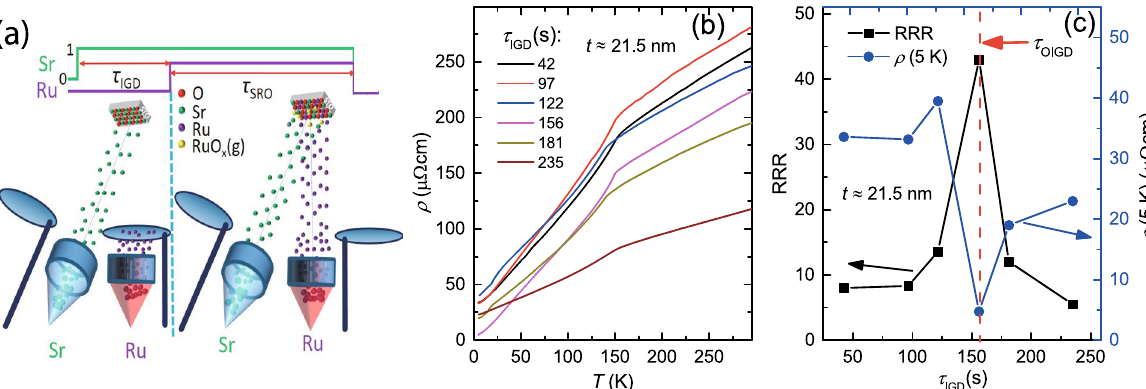
Figure 1. The influence of initial SrO growth condition on ρ (5 K) and RRRs of the SRO films on STO. ( a ) A schematic cartoon illustrating the growth of a SRO, where 0 and 1 refer to the shutter close and open, respectively. Ru shutter was opened when Sr flux had been turned on for a period of τ IGD . ( b ) For t ≈ 21.5 nm, the temperature dependent resistivity of SRO films grown with different τ IGD values. ( c ) shows a nonmonotonic variation of the corresponding RRR and ρ (5 K) with respect to τ IGD , revealing an optimum vlaue of τ IGD = τ OIGD for achieving lowest ρ (5 K) and thus highest RRR in SRO